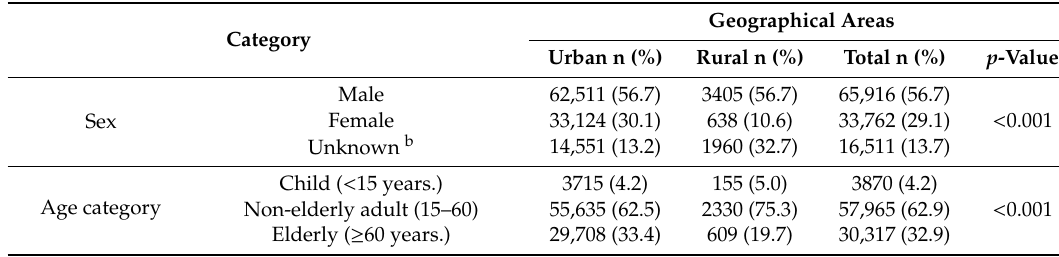
Table 3. Describing the Di ff erences of Missions Utilized per Patients in Categorical Variables Between Geographical Area Groups a